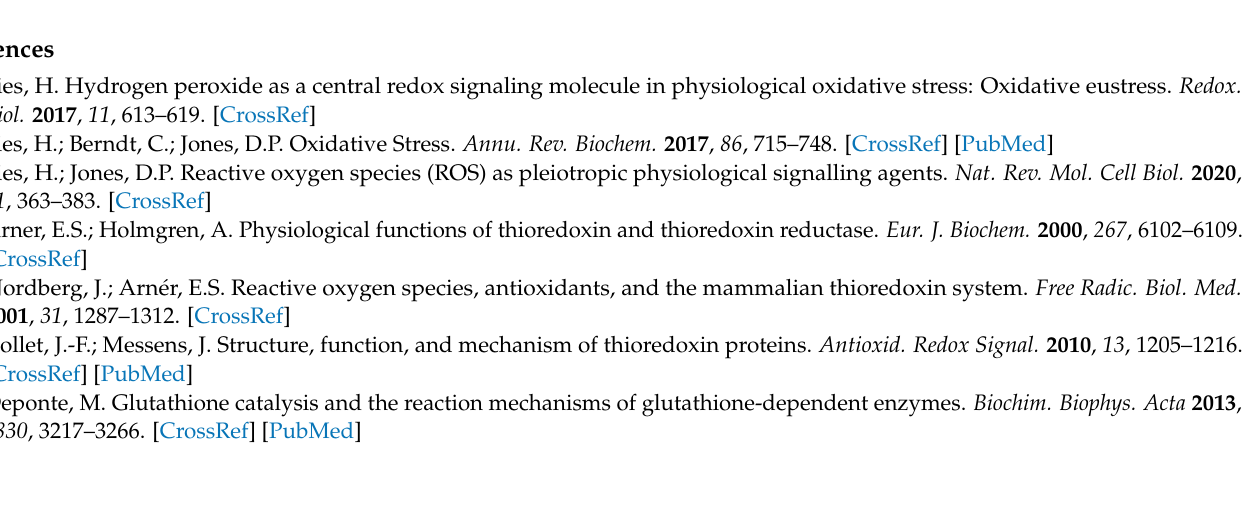
Figure S4: Analysis of CoA bound Rossmann-fold containing proteins; Table S1: Larger dataset of CoAlated mammalian proteins (CoAlome) and peptides; Table S2: Larger dataset of CoAlated bacte- rial proteins (CoAlome) and peptides; Table S3: Analysis of CoA-protein stabilization interactions using 35 published structures Containing CoA (CoAlated or CoA < 3 Å away from